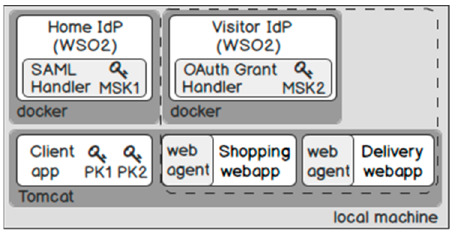
Figure 14. Test environment.